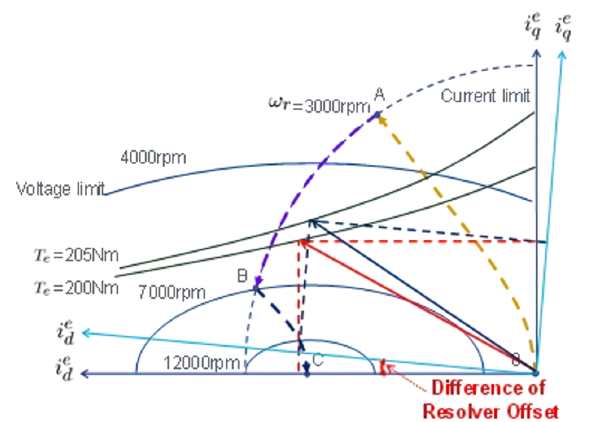
Figure 1. Torque variation due to difference of resolver offset.